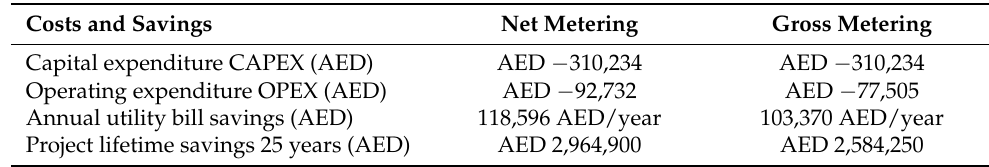
Table 13. Costs and Savings Results.